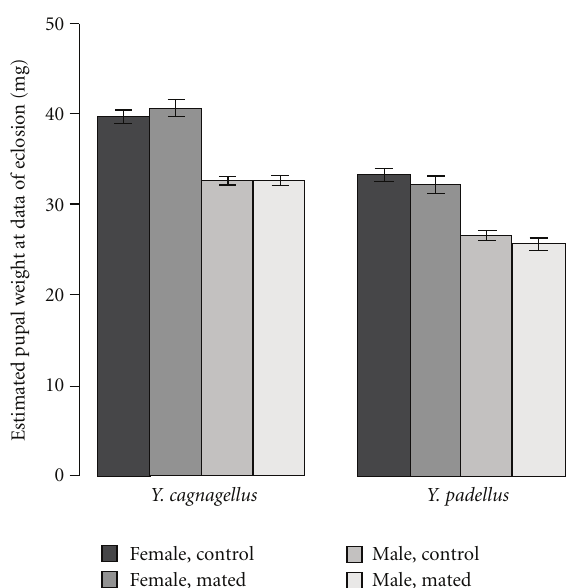
Figure 2: Lifespan (in days) as a function of species ( Yponomeuta padellus or Yponomeuta cagnagellus ) , sex, and mating status (virgin control or once